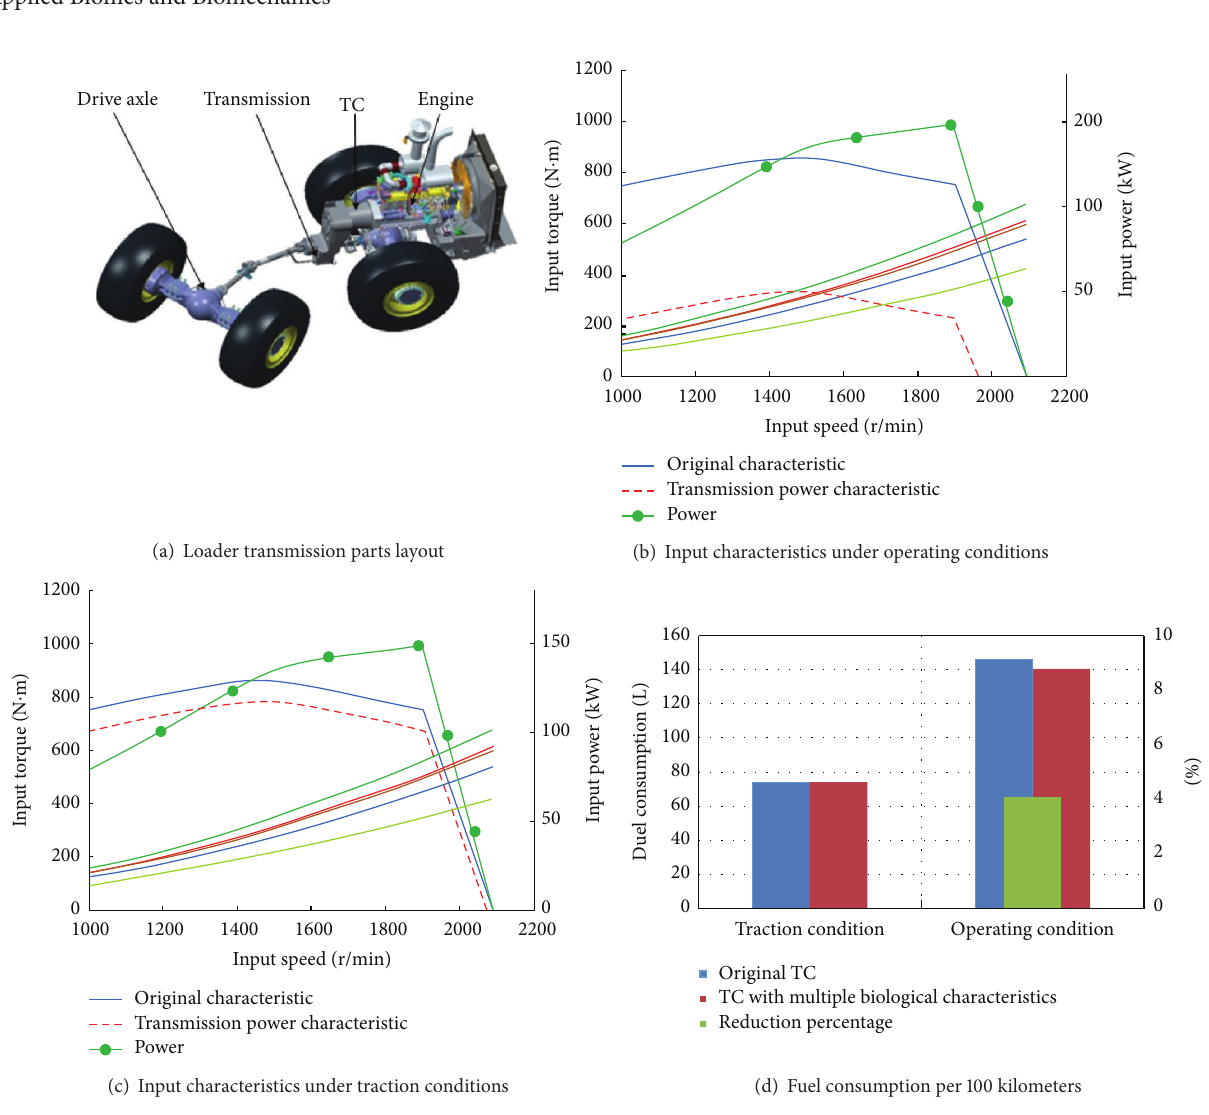
Figure 18: Fuel consumption of loader with multiple biological